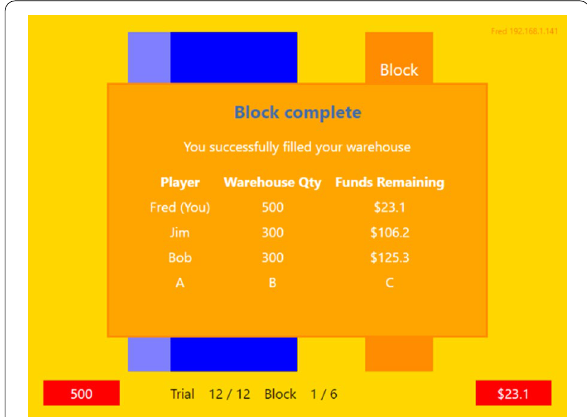
Fig. 1 Example of the game interface. a Participants available funds, b participants current warehouse stock, c available stock for purchase,